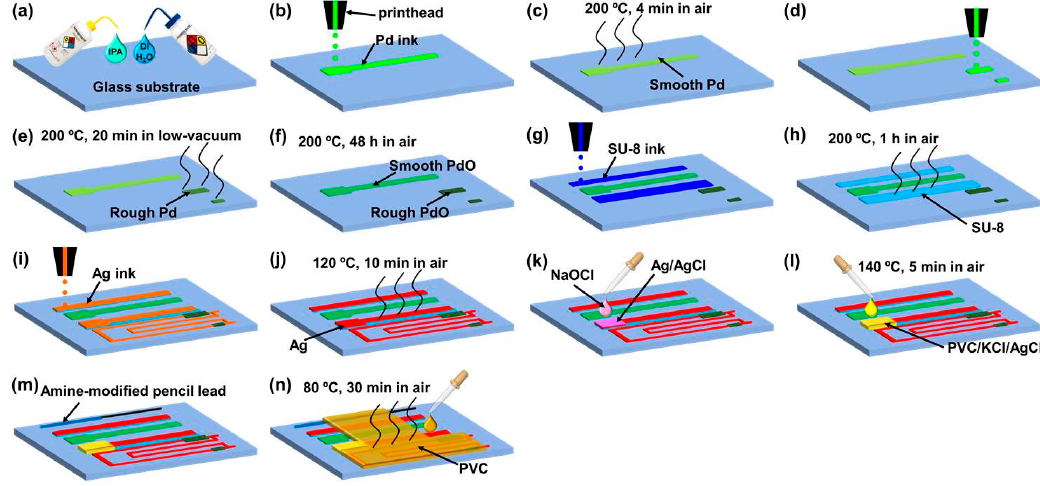
Figure 3. Inkjet printing process for an integrated sensor for pH, chlorine, and temperature [12]. For stretchability, the mechanisms outlined in Section 2 have all been used with inkjet printing.